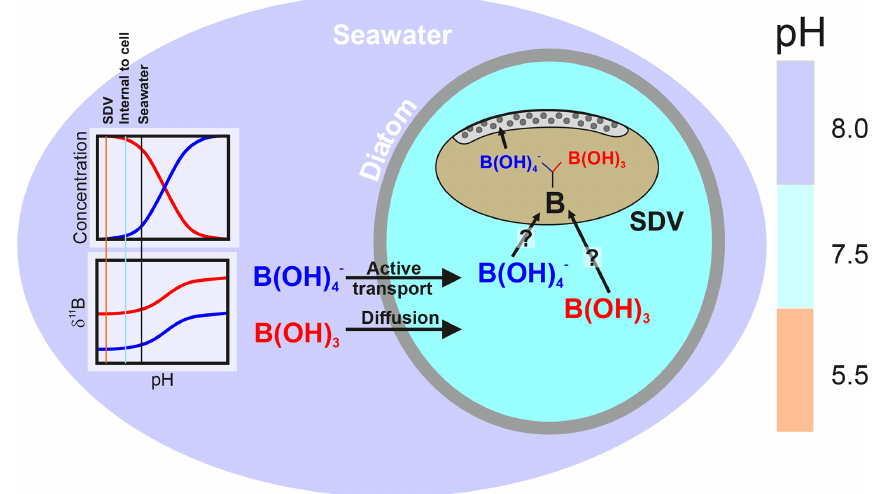
Figure 8. Schematic of the model described herein for boron uptake by T. weissflogii . The speciation behaviour and isotopic composition of boron is also shown in the insert, with the aqueous species colour coded (red represents boric acid, and blue represents borate ion). Seawater . While it remains unclear how boron enters boric acid diffuses into the diatom cell, and the borate ion is actively transported, with HCO − 3 the silica deposition vesicle, once inside it respeciates into borate ion and boric acid, with the borate ion being incorporated into the frustule. The isotopic composition of internal boron is a function of external pH, which sets the isotopic composition of the incoming species, as well as the balance between active borate ion transport and passive boric acid diffusion. The compartments are colour coded according to approximate pH (scale on the